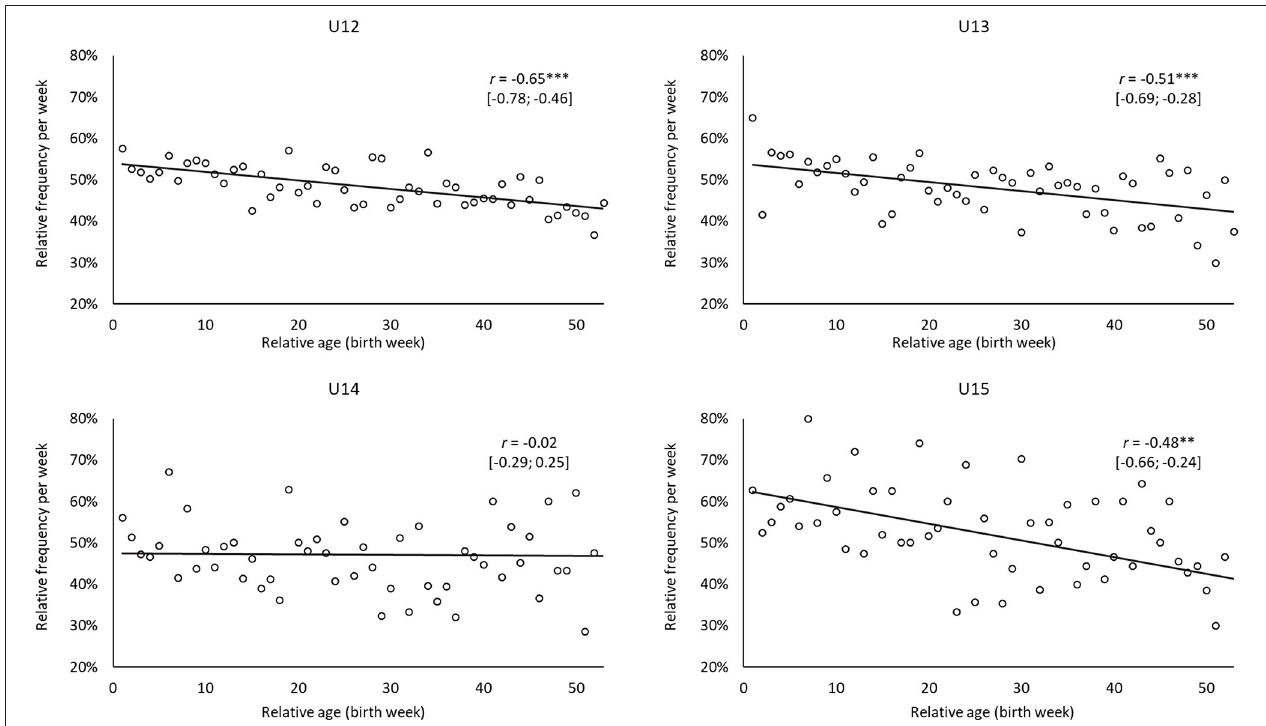
FIGURE 3 | Relative frequencies for holistic ratings of current player performance per week of birth for players whose current performance was assigned to the level of the extended squad (Level 2) or the core team for regional association (Level 3) by coaches for the age groups U12 to U15. p < 0.05; ** p < 0.01; and *** p <